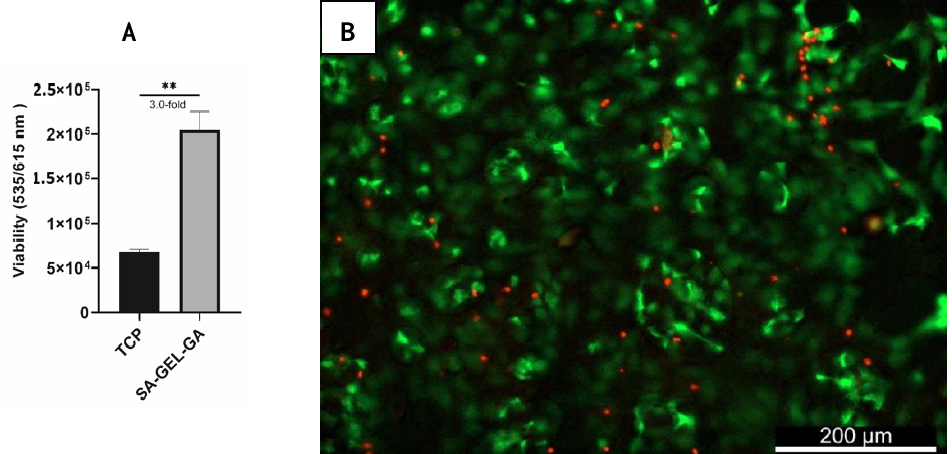
Figure 1. ( A ) Quantified viability of bAChs on SA – GEL – GA compared to TCP at day 45 as evaluated by PrestoBlue fluorescence assay at excitation/emission wavelengths (535/615 nm) (n = 3, mean ± standard error of the mean (SEM), ** p < 0.01). ( B ) Representative live/dead image of bAChs grown in SA – GEL – GA on day 45 using calcein-AM (green: live), and propidium iodide (dead: red), magnification: 10X.